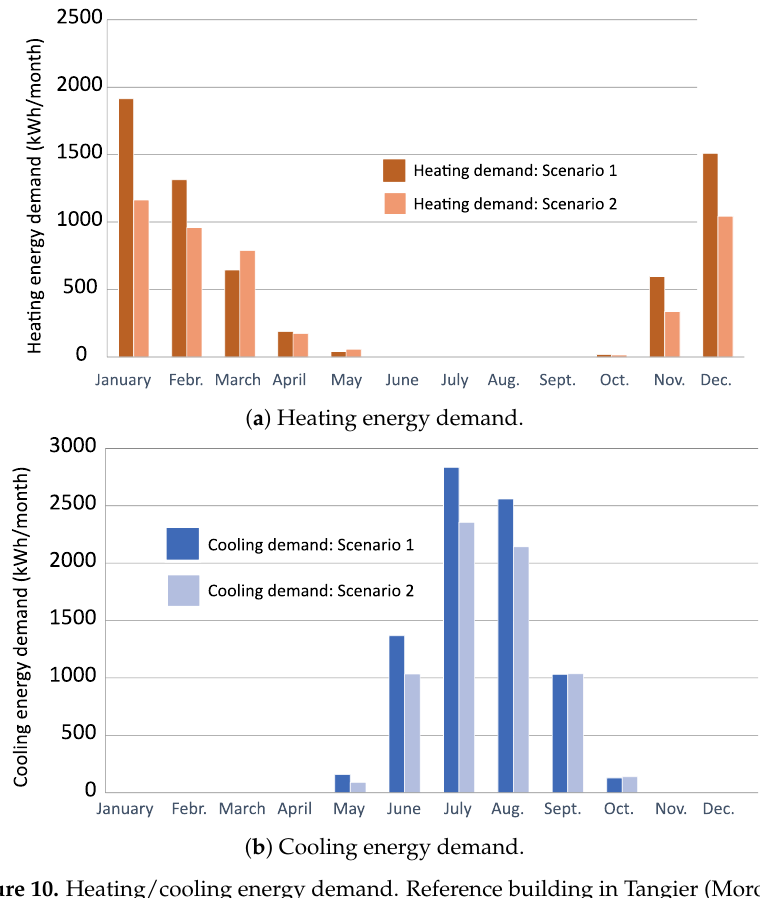
Figure 10. Heating/cooling energy demand. Reference building in Tangier